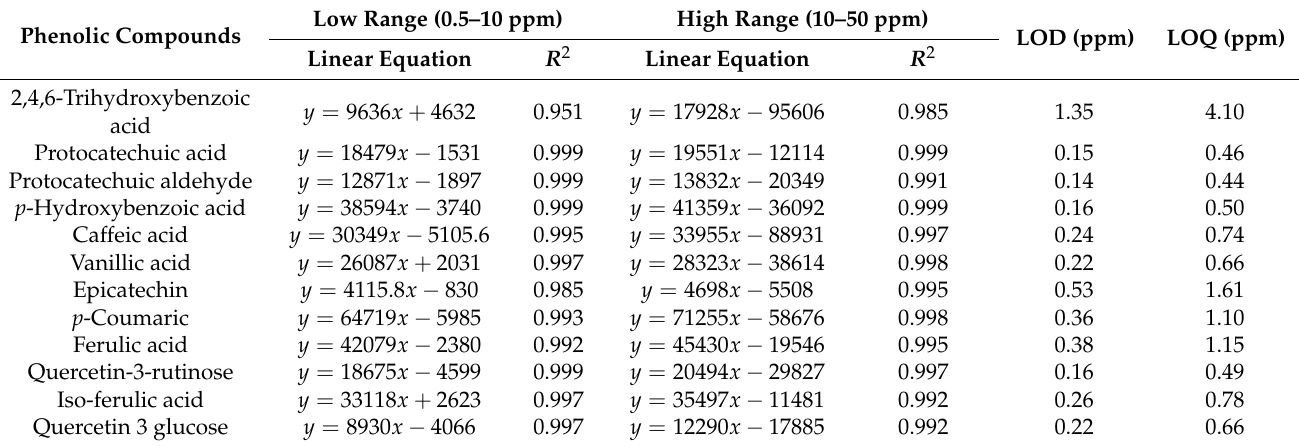
Table 2. Performance of the UPLC-PDA method for individual phenolic